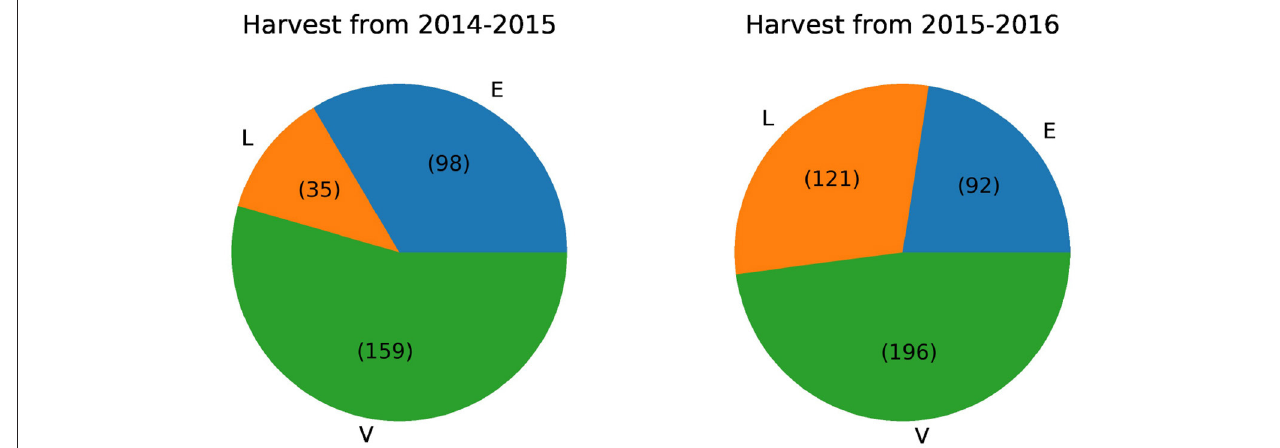
FIGURE 2 | Number of instances for each olive oil class in harvests from 2014 to 2016.